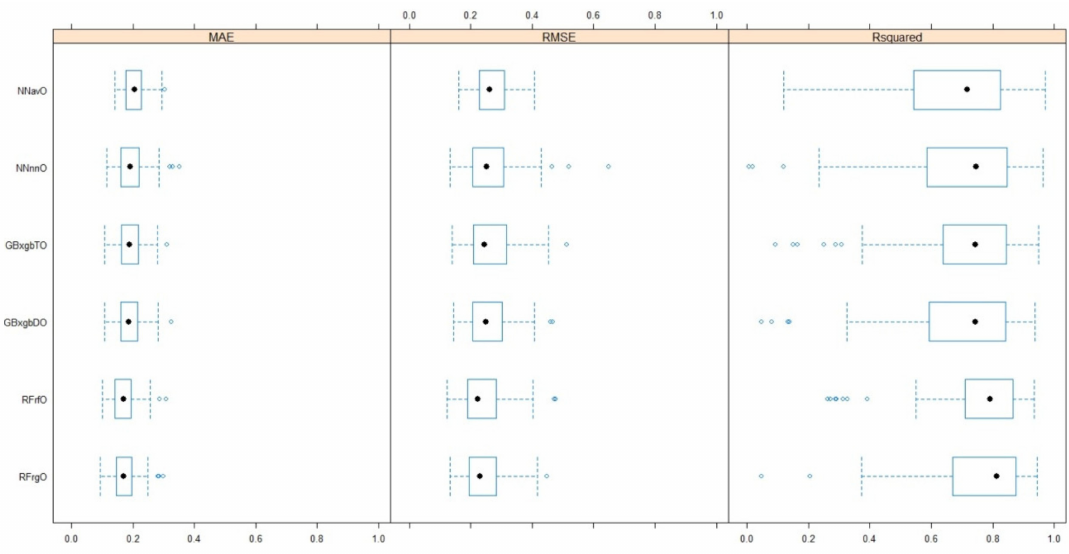
Figure 5. Results of the optimized machine learning (ML)